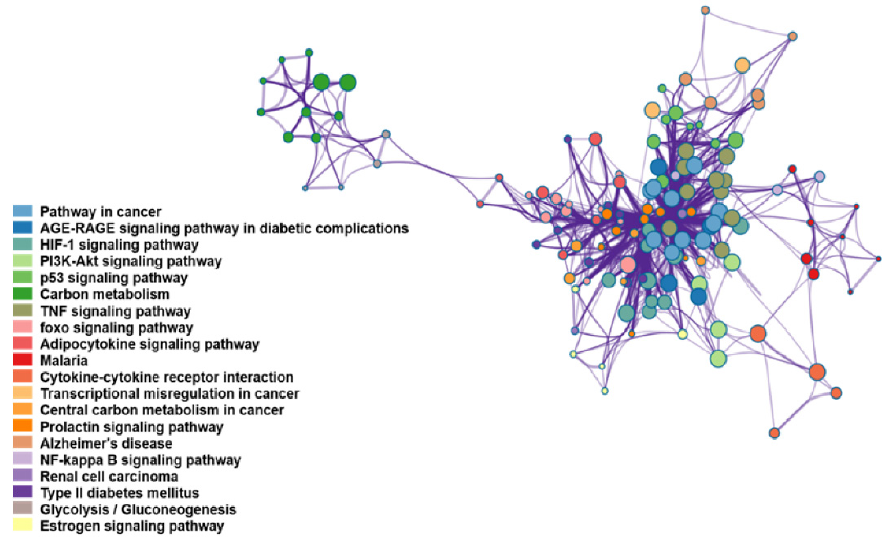
Figure 5. The result of KEGG pathway enrichment analysis.